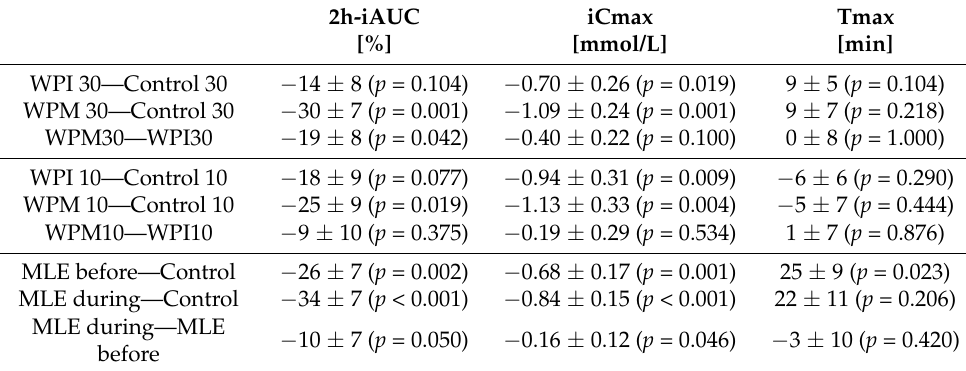
Table 4. Pairwise comparison with effect size (mean ± SE) and p -value (paired t -test) for the nine comparisons of the highest interest, with n = 14 for the protein premeal study and n = 30 for the MLE